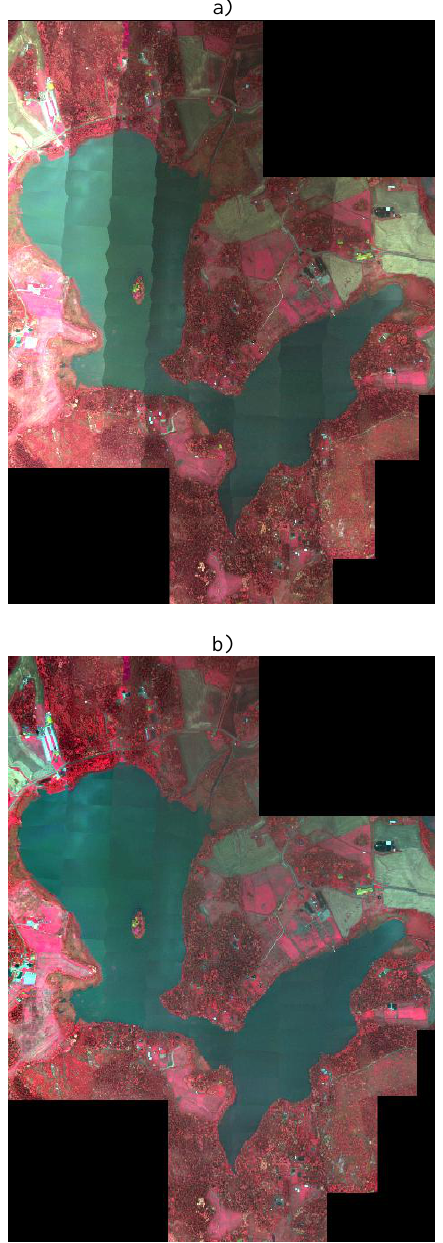
Figure 6. The spectral datacube mosaic with 20 layers collected by the manned aircraft (in the image composite layers 17, 8 and 3 are used) a) no radiometric corrections and b) the corrected image mosaic. North is up and East is right. Data used in georeferencing © The National Land Survey of Finland, Colour orthophoto and Elevation model 10 m, 01/2013, http://www.maanmittauslaitos.fi/en/NLS_open_data